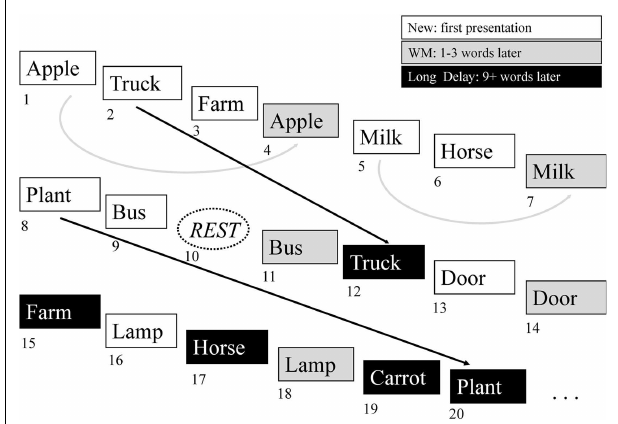
FIGURE 1 | Continuous verbal episodic memory task .The episodic memory task used in the present study features continuous encoding and recognition of simple words.The participant responds to each item by indicating whether it is a new item (not previously heard) or an old item (previously heard).The new items represent episodic encoding, as the participant must encode these items for possible future presentation.The old items represent episodic recognition and are divided into working memory items (WM), where the item was presented one to three words prior to the recognition episode, and long delay memory items, where the target item was presented nine or more words prior to the recognition item event. See the text for further description of this